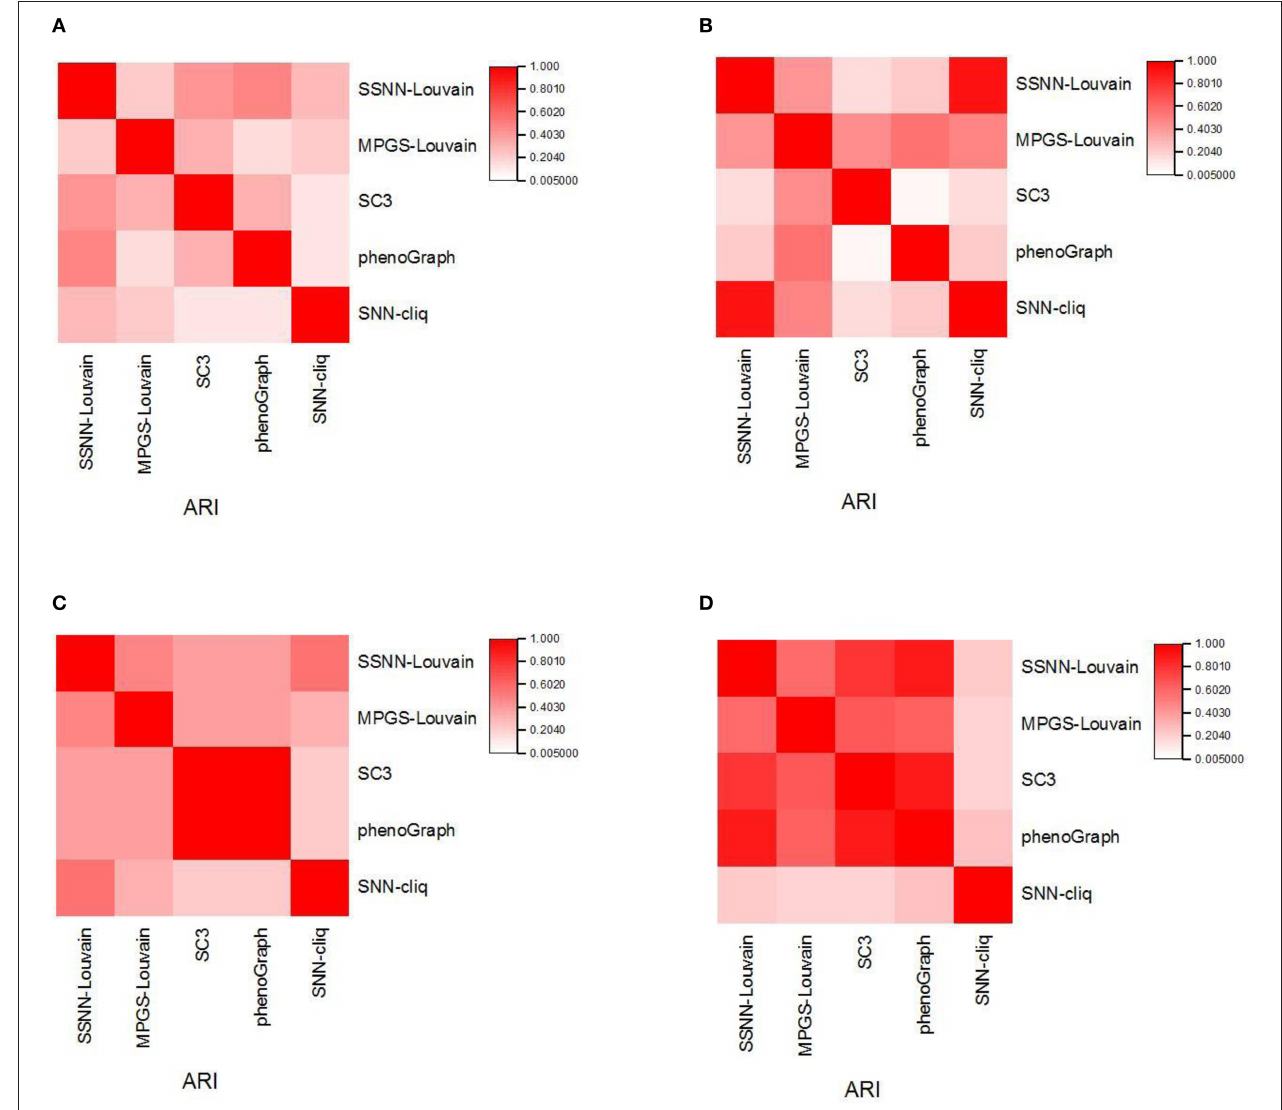
FIGURE 2 | The similarity of the individual clustering methods. (A) Liu dataset; (B) Ramskold dataset; (C) Yan dataset; (D) Yeo dataset.